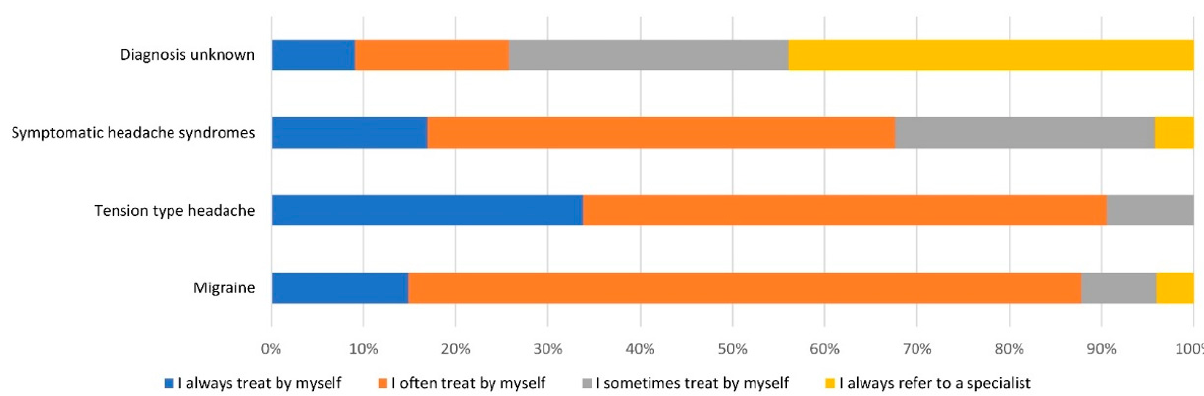
Figure 1. Treatment patterns reported by general practitioners. Seventy-six general practitioners (GP) from the neighbouring districts of the specialised outpatient clinic reported, which patients they usually treat by themselves and which patients they usually refer to a specialist. Migraine is in 86% of cases either always ( n = 11) or often ( n = 54) treated by general practitioner. Tensions type headaches are equally frequently, i.e., 88%, treated in the majority of cases by the GP. In contrast, patients with symptomatic headaches or an unknown diagnosis are more often not treated by GPs but referred in 30% or 64% of cases, respectively.